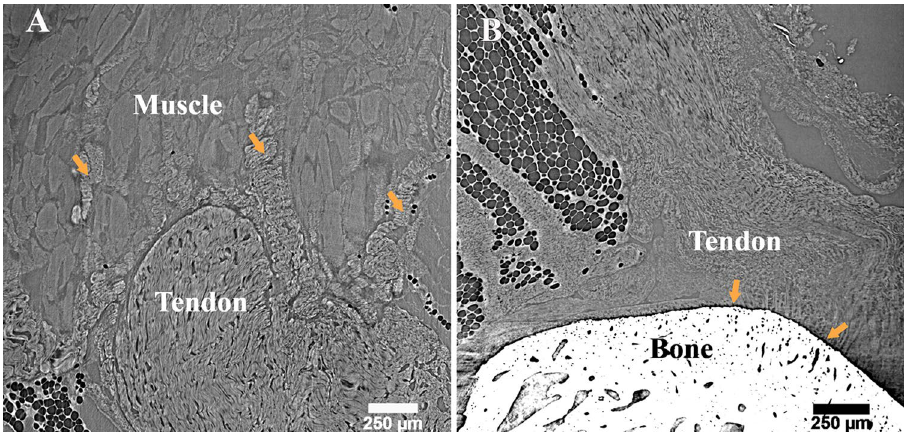
Figure 5. Fiber organization at the junctions. SR-PhC-μCT (HNAM) longitudinal views of: ( A ) The tendon– muscle junction showing tendon fiber intercalation into the muscles (orange arrows); ( B ) the tendon-bone junction characterized by a sharp passage from the tendon to the bone (orange